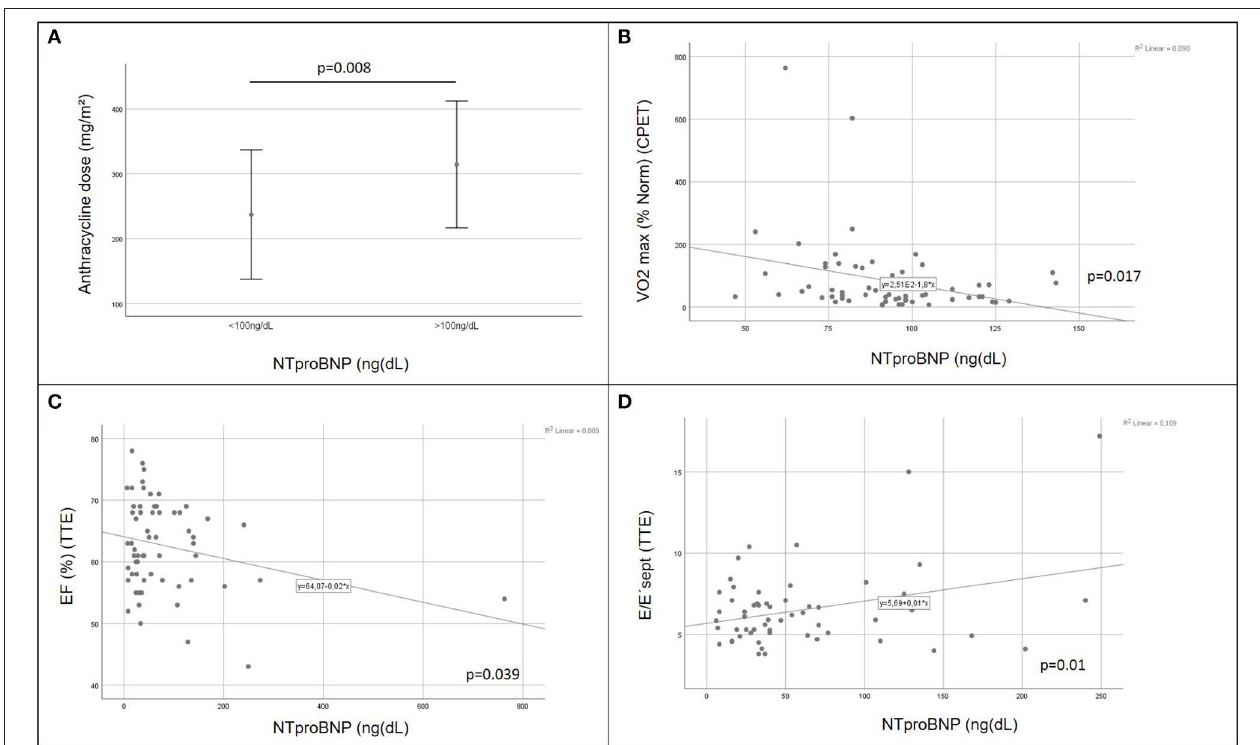
FIGURE 3 | Role of the laboratory biomarker NTproBNP in cardiovascular impairment of childhood cancer survivors. Patients with elevated NTproBNP values were exposed to significantly higher doses of cumulative anthracycline compared to patients with NTproBNP values within the normal range [ (A) independent t-Test 0.008]; increasing NTproBNP values correlated with decreasing exercise capacity [VO 2 max (% norm), (B) Pearson correlation p = 0.017], decreasing echocardiographic systolic left ventricular function [EF, (C) Pearson correlation p = 0.039], and increasing echocardiographic diastolic dysfunction parameters [tissue Doppler septal E/E’ratio, (D) Pearson correlation p = 0.01]; CPET, cardiopulmonary exercise testing; VO 2 max (% norm), peak respiratory oxygen uptake in % predicted; EF, Ejection Fraction; TTE, transthoracic